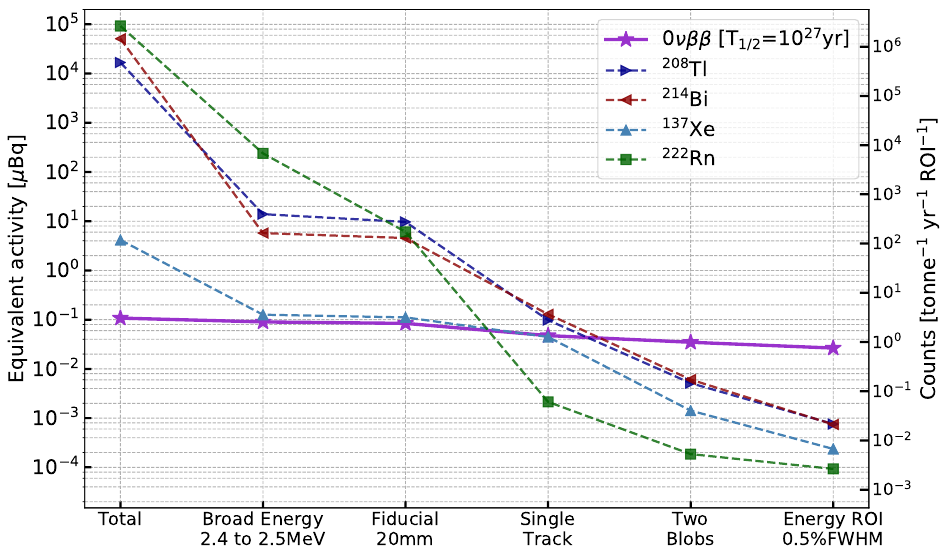
Figure 9 . Equivalent background activity, background rate and signal rate as a function of the cuts for all sources considered. Here, the half life of 136 Xe was assumed to be 10 27 yr , and is shown just for